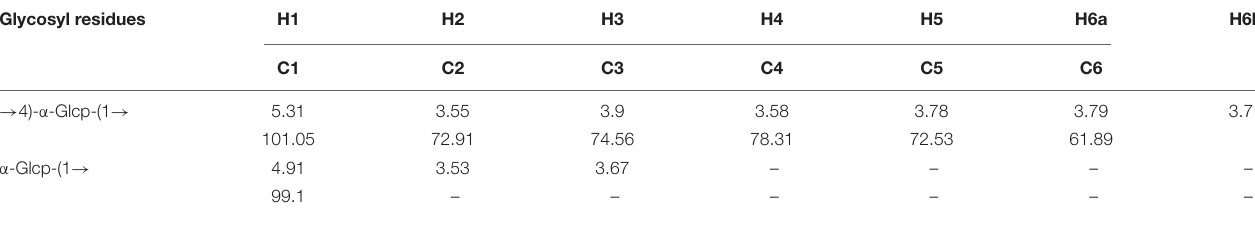
TABLE 2 | 1 H NMR and 13 C NMR spectral assignments for